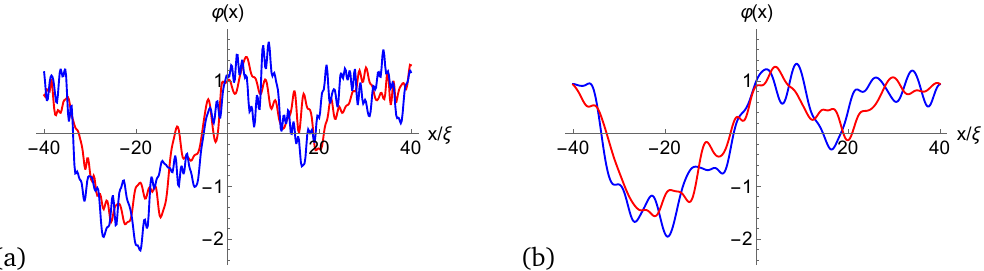
= 32ms, and for a different 1